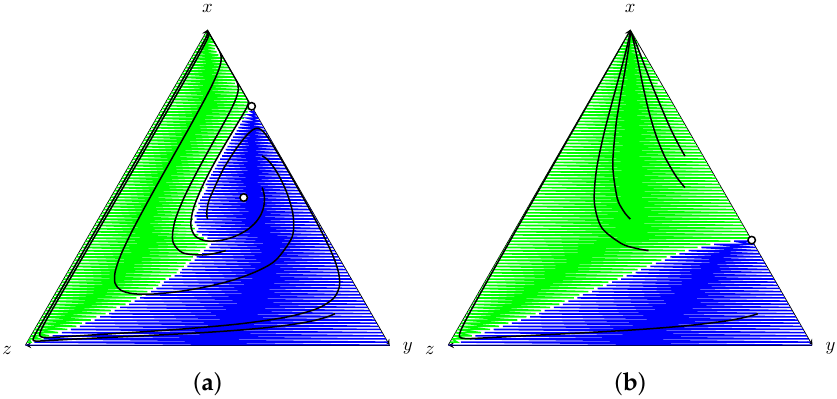
Figure 9. The behavior of x in the trajectories for each possible initial value. The green area represents initial values where the frequency of cooperators x increases along the orbit; the blue area represents initial values where at some point of the trajectories x decreases. The black lines are trajectories from several initial values in the simplex. n = 5, r = 3, and σ = 1, and values of d are ( a ) d = 0.22 and ( b ) d =